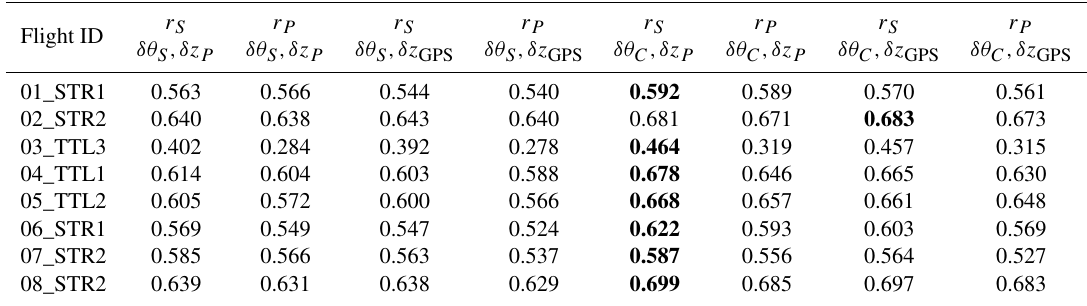
Table 4. Averages of the 50% of correlation coefficients with the largest values between δθ and δz . The Spearman and Pearson coefficients are displayed for the four combinations between δθ S or δθ C and δz P or δz GPS . About 1200 coefficients are averaged here for each flight. The largest correlation coefficient is displayed in bold for each flight. The larger the correlations, the smaller the impact of instrumental noise (see